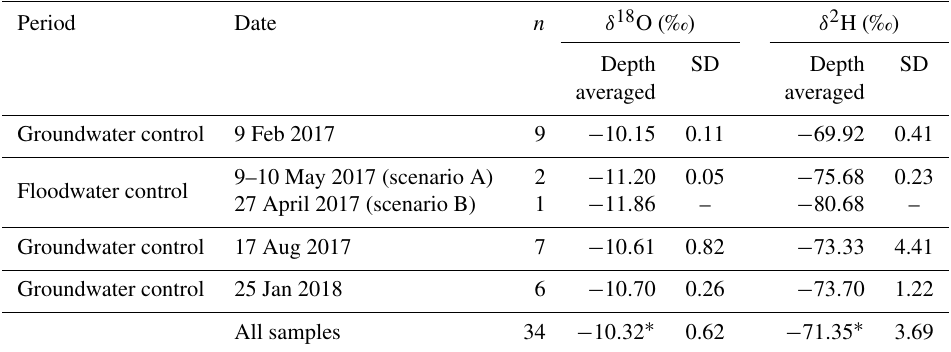
Figure 6. Observed and modelled depth-average isotopic composition of the lake ( δ L ) for δ 18 O (a, b) and δ 2 H (c, d) from 9 February 2017 to 25 January 2018 for scenarios A and B. The hollow and solid blue circles correspond to lake A water samples collected at ≤ 2 and > 2m, respectively. The modelled δ L is fitted against the three depth-averaged δ L and an additional sample collected at ≤ 2m depth on 9–10 May 2017 (scenario A) and 27 April 2017 (scenario B). These samples are marked by the hollow red squares. The grey shaded area corresponds to the floodwater control period. The error bars correspond to the standard error in the samples for each campaign. The dashed lines represent the modelled δ L when considering that 25% to 100% of the outputs from the lake during the floodwater control period were temporally stored in the aquifer and discharged to the lake as floodwater-like inputs ( δ I ). s Table 1. Observed depth averaged (or mean) and standard deviation (SD) of isotopic composition of lake A for the sampling campaigns in February 2017, August 2017, and January 2018 and all samples. The isotopic composition of the samples collected at the surface of lake A on 9–10 May and 27 April 2017 are also listed. The asterisks ( ∗ ) indicate that a mean value was calculated (instead of a depth-averaged